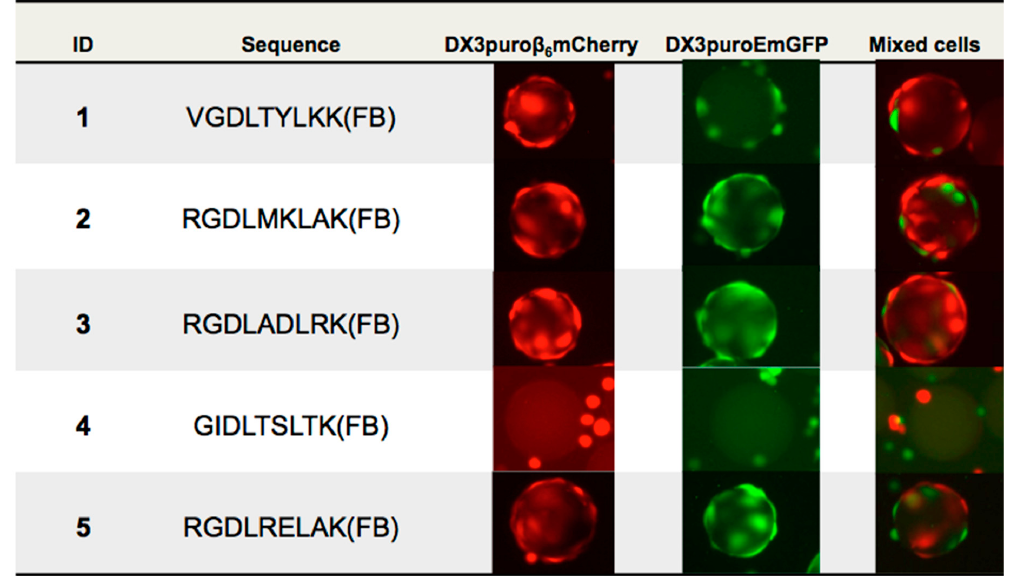
Figure 2. Representative pictures of 1 – 5 incubated with ( a ) DX3puro β 6 mCherry ( α v β 6 + , red); ( b ) DX3puroEmGFP ( α v β 6 − , green); and ( c ) mixed DX3puro β 6 mCherry ( α v β 6 + , red), and DX3puroEmGFP ( α v β 6 − , green) cells 3 h post ‐ incubation.